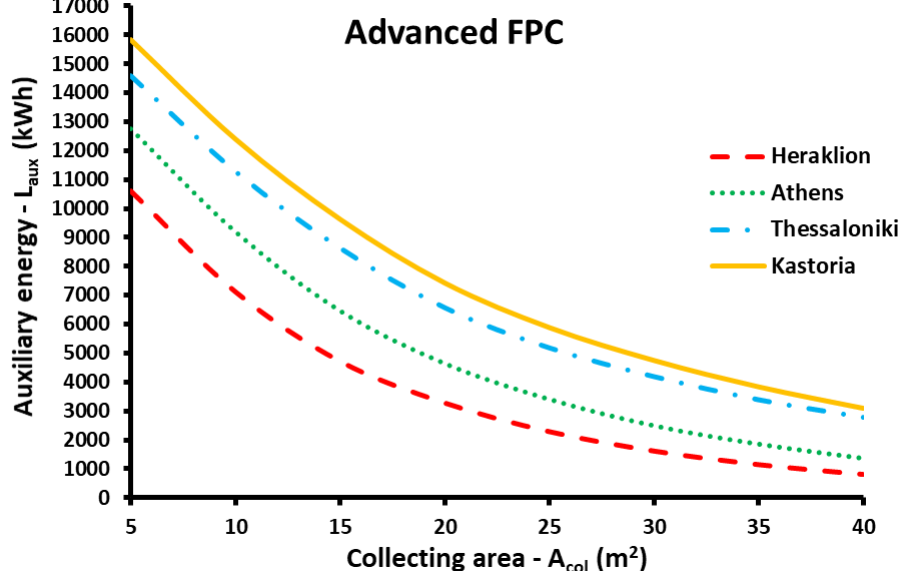
Figure 17. Auxiliary energy consumption with optimum tilt angles for advanced FPC.